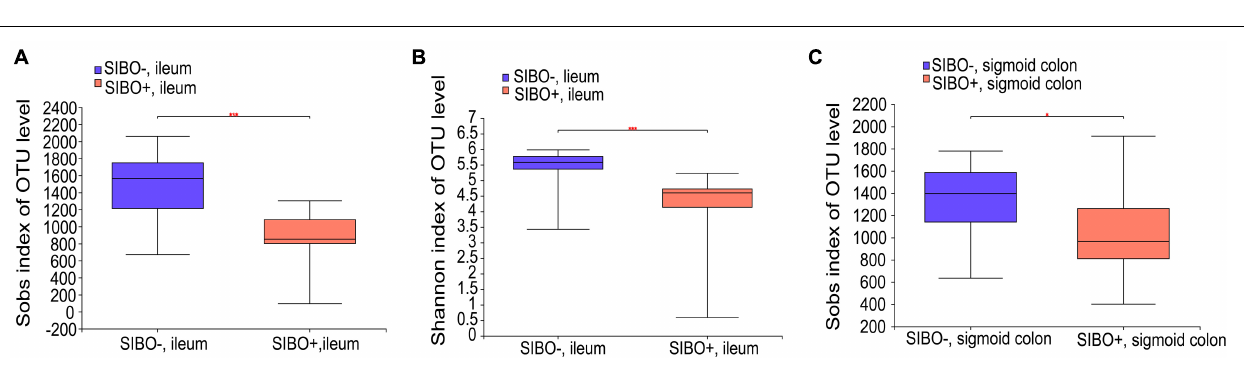
FIGURE 3 | Distinct bacterial composition at the genus level in the mucosal and fecal samples of all subjects. (A) The predominant genera in the 4 types of samples. (B) Bacteroides ( P < 0.001), Agathobacter ( P < 0.001), and Roseburia ( P < 0.01) were more abundant in the fecal samples compared to the mucosal samples. On the other hand, the relative numbers of unclassified_k_norank_d_bacteria ( P < 0.001), lactobacillus ( P < 0.001), Ralstonia ( P < 0.001), and Streptococcus ( P < 0.001) were more enriched in the mucosa compared to those in the feces. (C,D) Bacteroides ( P < 0.05), Faecalibacterium ( P < 0.01), Blautia ( P < 0.001), Subdoligranulum ( P < 0.01), Bifidobacterium ( P < 0.01), and Agathobacter ( P < 0.05) were relatively less abundant, whereas Streptococcus ( P < 0.01), Neisseria ( P < 0.001), Veillonella ( P < 0.001), and Prevotella_7 ( P < 0.001) were more abundant in the mucosa of the duodenum than in the ileum and sigmoid colon. The genera with < 0.1% abundance were aggregated as “others.” Kruskal–Wallis H test was used to test differences among multiple groups with fdr controlling the false discovery rates. Wilcoxon rank-sum test was used to test differences between two groups. * P < 0.05, ** P < 0.01, and *** P < 0.001.